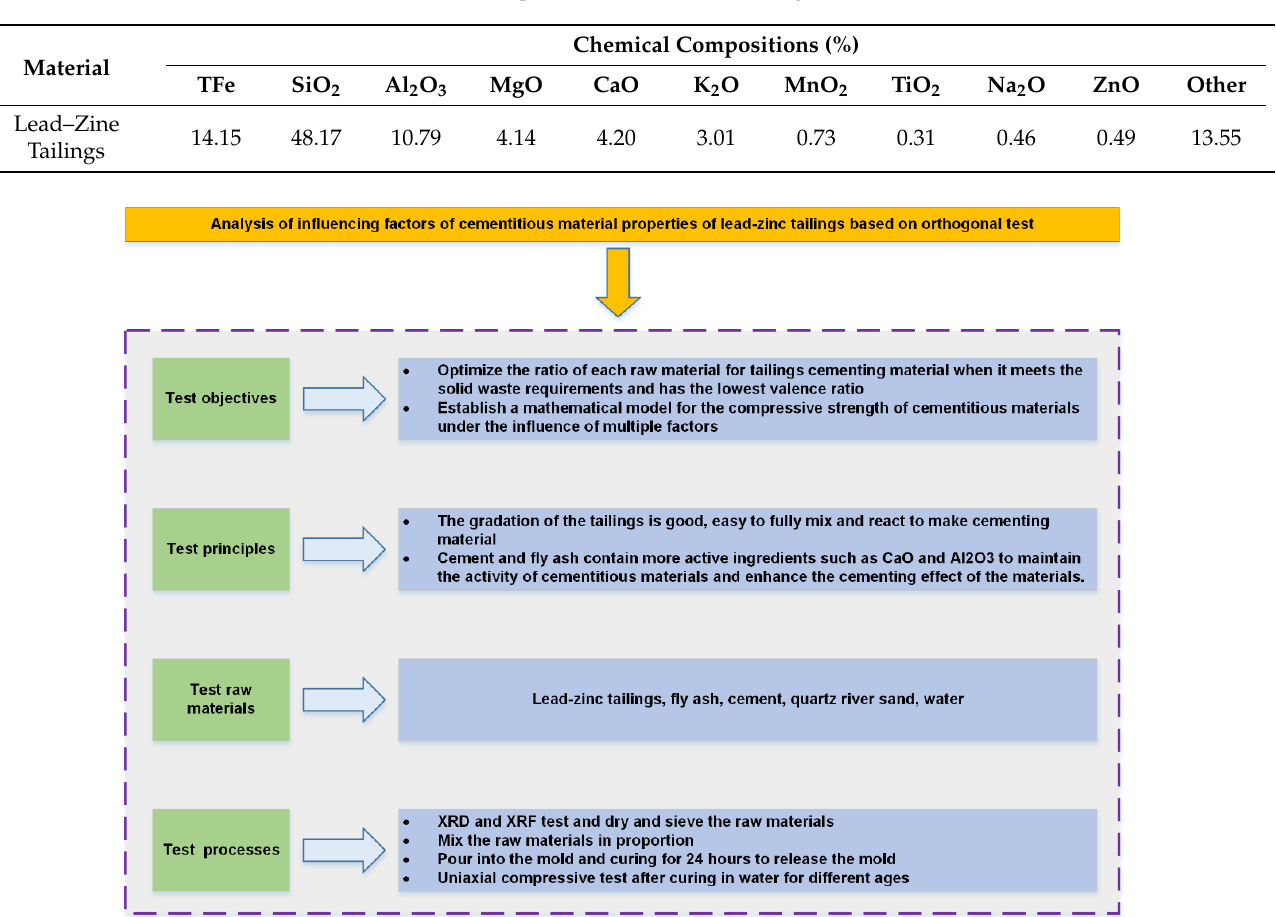
Figure 2. XRD patterns of lead–zinc tailings samples. Table 2. Chemical compositions of lead–zine tailings.